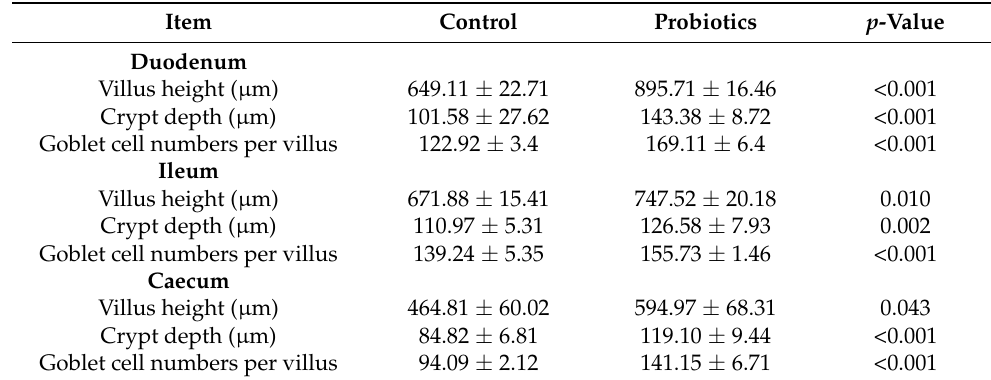
Table 3. Effect ofthe multi-strain probiotic Slab51 ® supplementationon the intestinal morphology of guinea fowl ( Numida meleagris ). Item